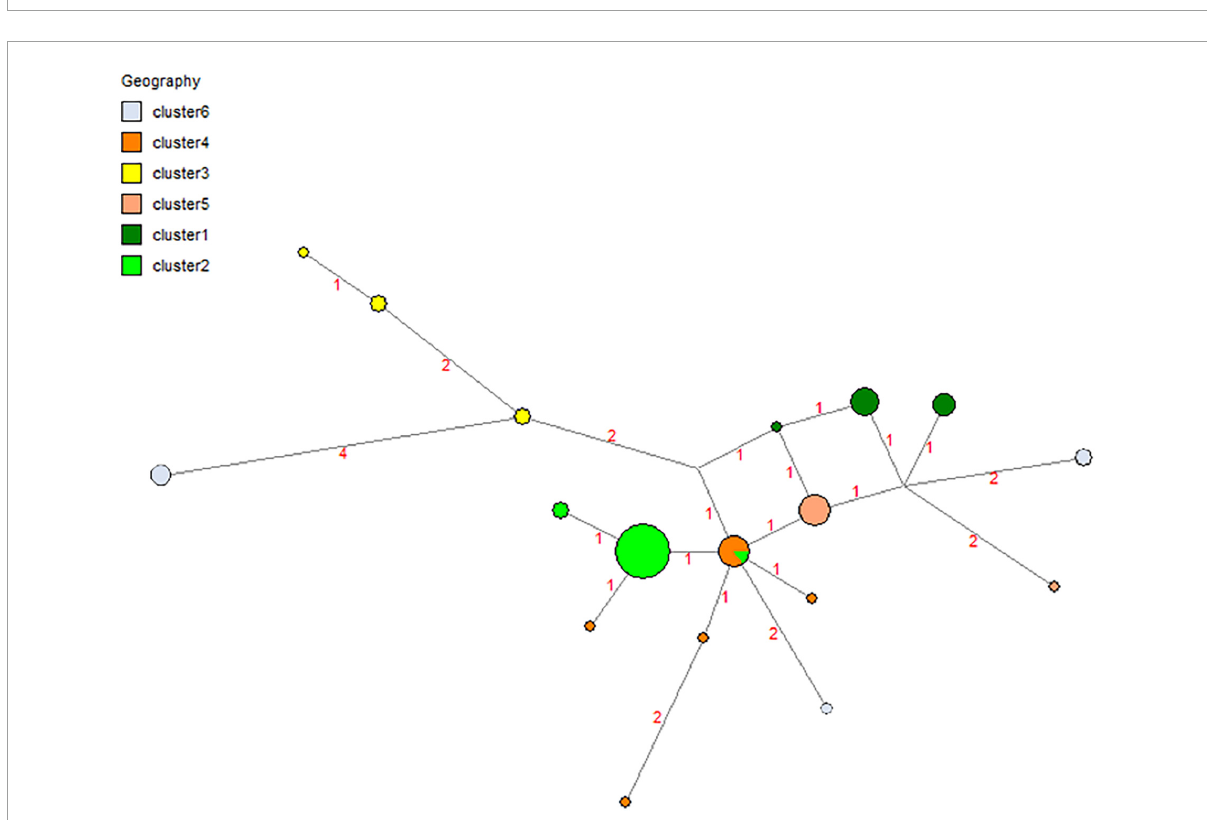
FIGURE6 Haplotype network showing shared haplotypes of the observed populations obtained using the Median Joining